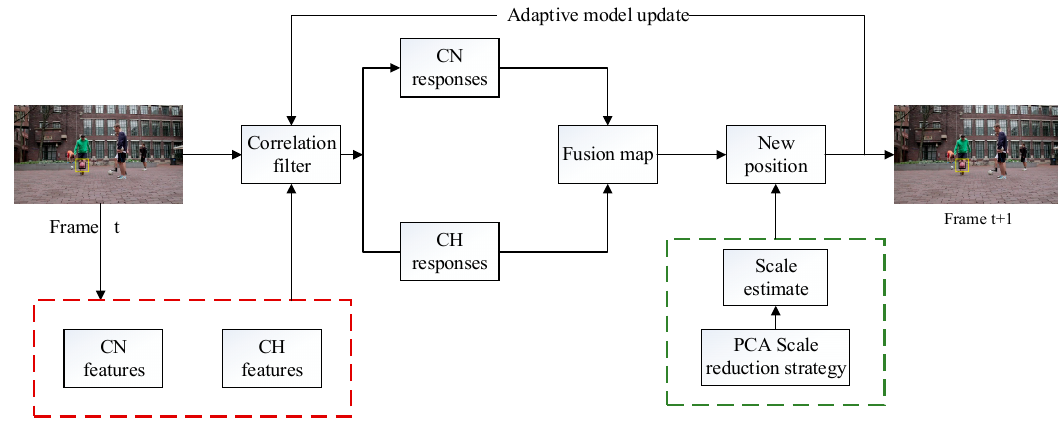
Figure 1. Framework of the proposed tracking method.